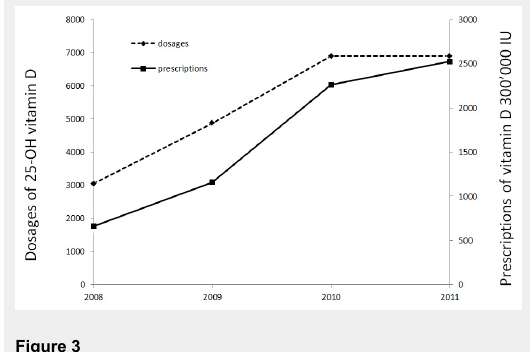
Evolution of vitamin D dosages and prescriptions between 2008 and 2011 in Lausanne University Hospital